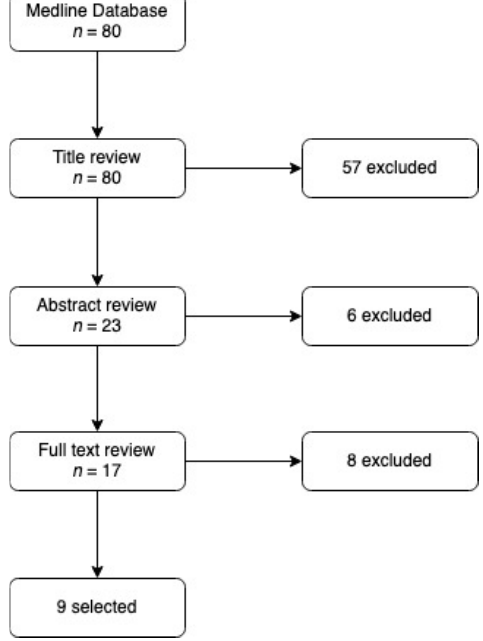
Figure 1. Flow diagram of the review process.